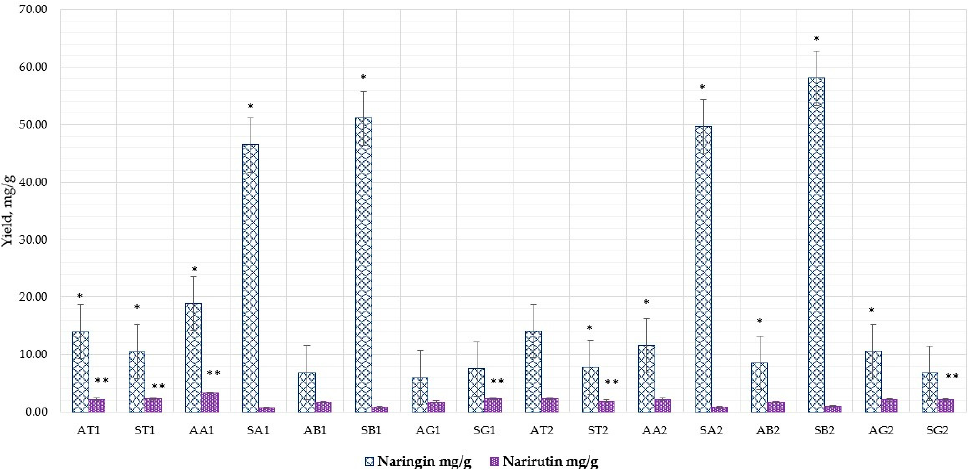
Figure 11. The quantitative yield of naringin and naringenin using excipients (1%). Sample codes are provided in Table 1. Results are means ± SD ( n = 3). Naringin *: AA1 p < 0.05 vs. AT1 *; SA1 * p < 0.05 vs. ST1 *; SB1 * p < 0.05 vs. ST1 *; SB1 * p < 0.05 vs. SA1 *; AA2 p < 0.05 vs. AB2;